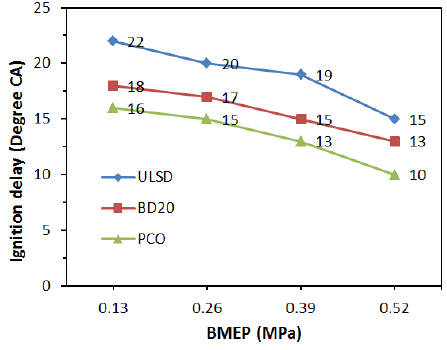
Figure 5. Effect of BMEP on ignition delay for test fuels.